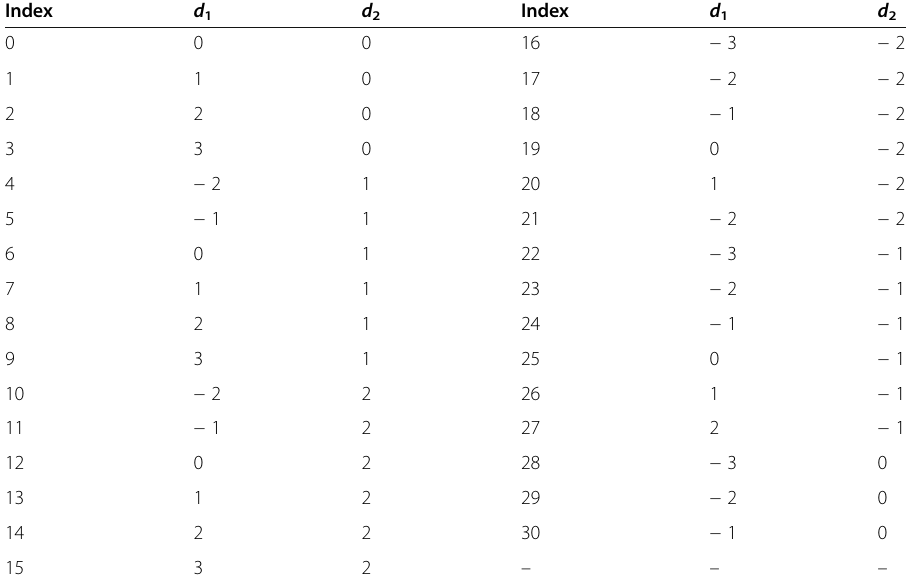
Table 3 Codebook when n = 2 and x = 3 with b 1 = 1 and b 2 =